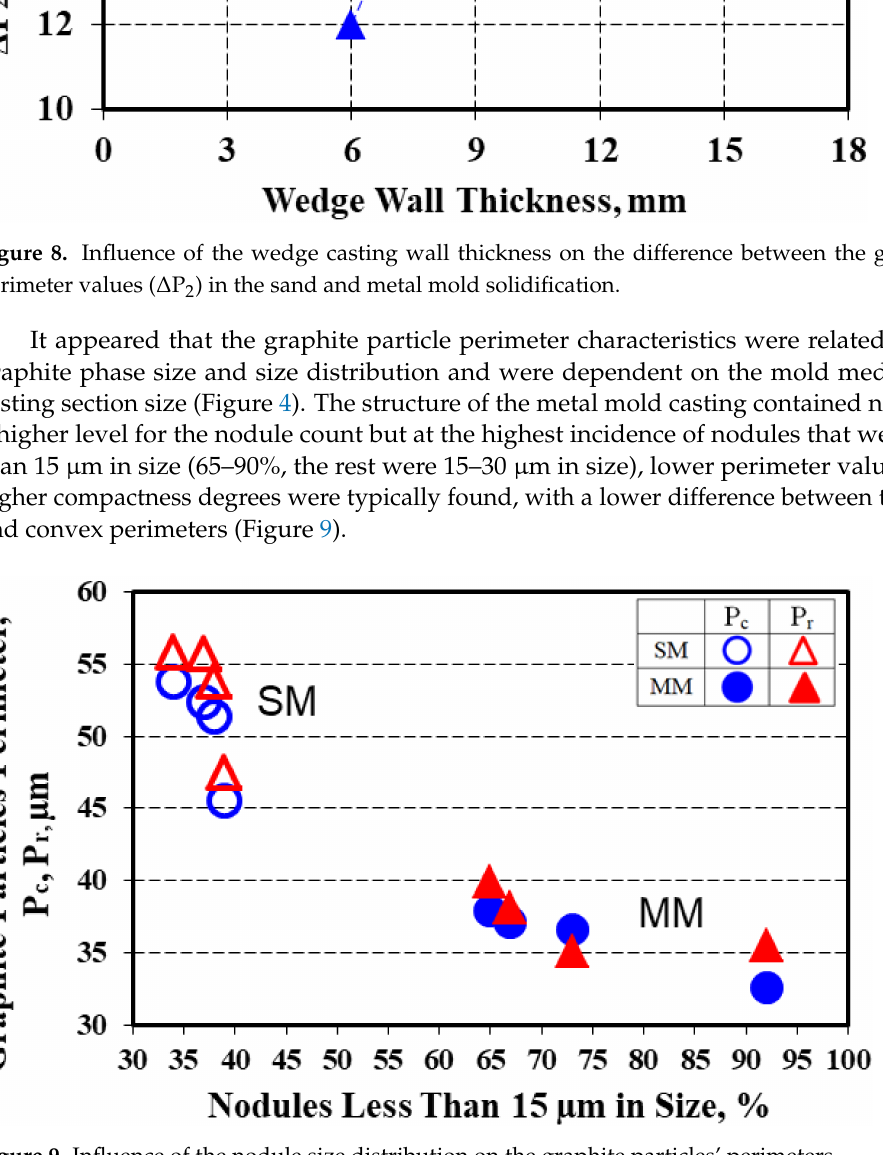
Figure 9. Influence of the nodule size distribution on the graphite particles’